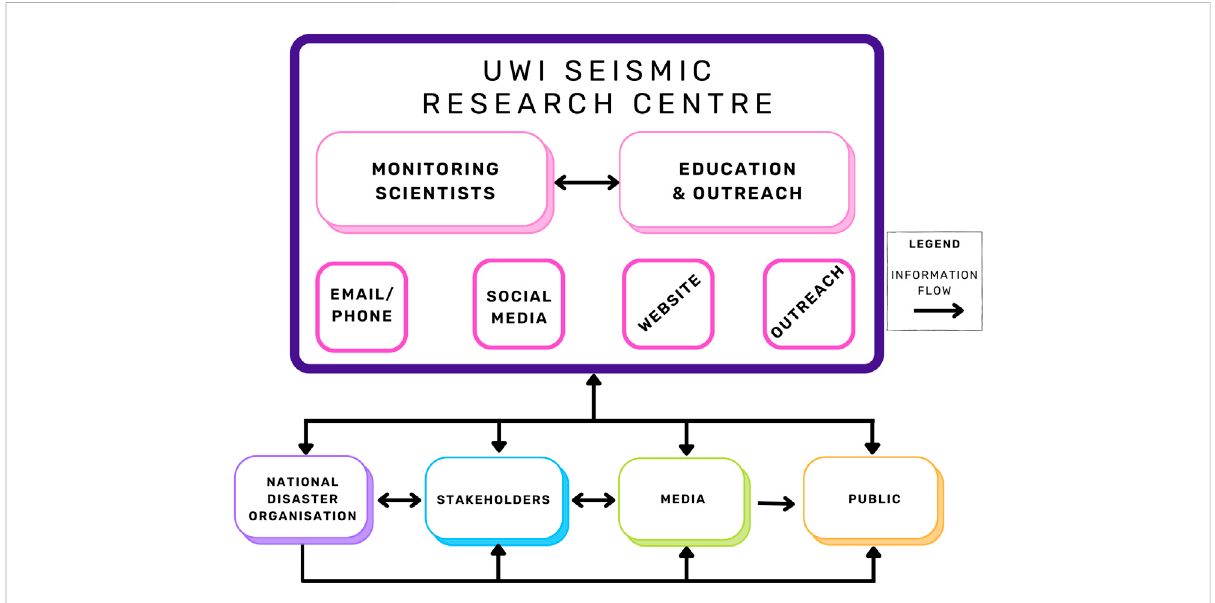
FIGURE 1 Generalised information fl ow between The UWI Seismic Research Centre and Eastern Caribbean volcano risk management